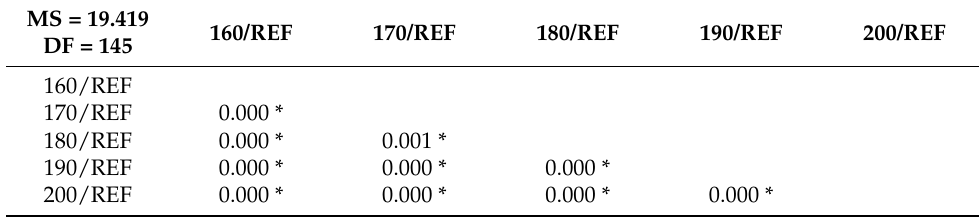
Table A10. Duncan ´ s multiple range test for changes in total colour difference. MS =